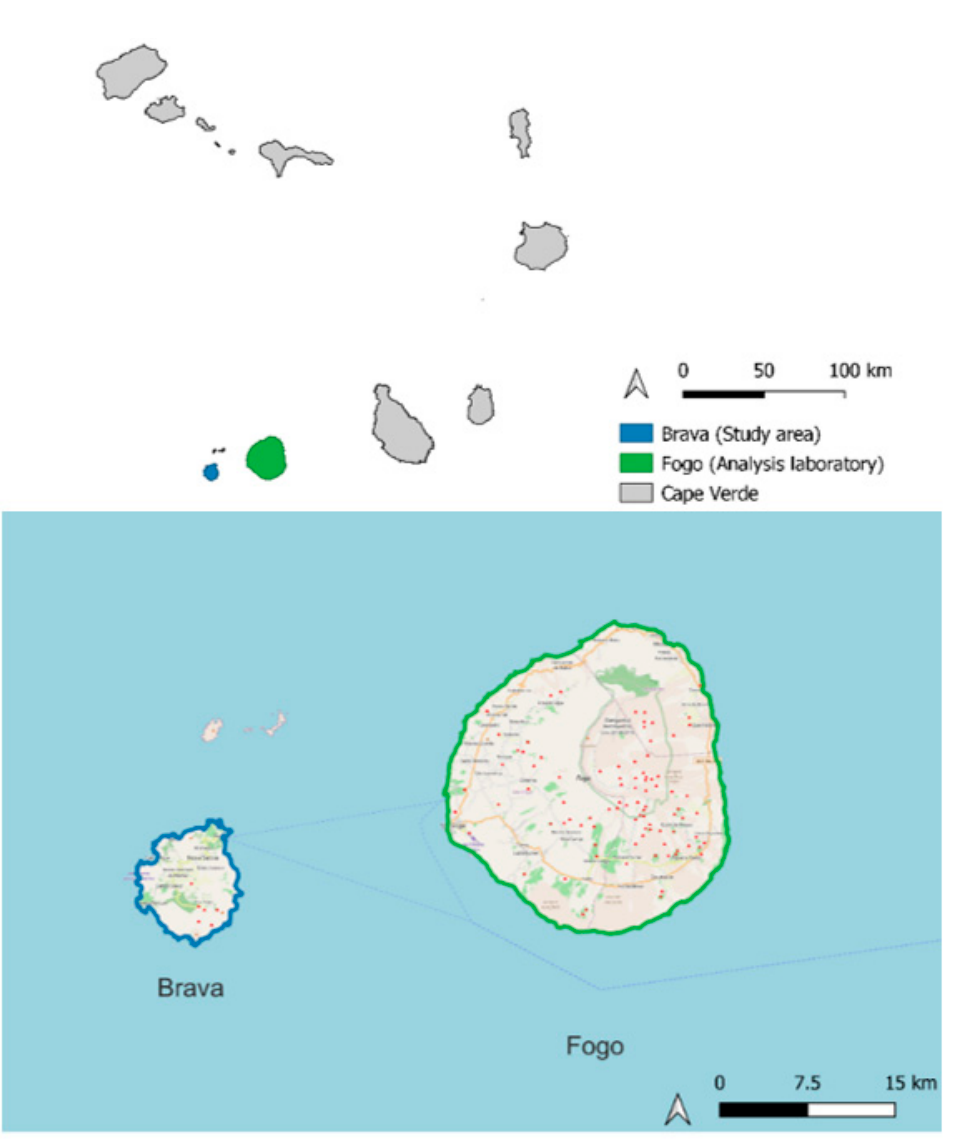
Figure 1. Location of Brava and Fogo Islands.